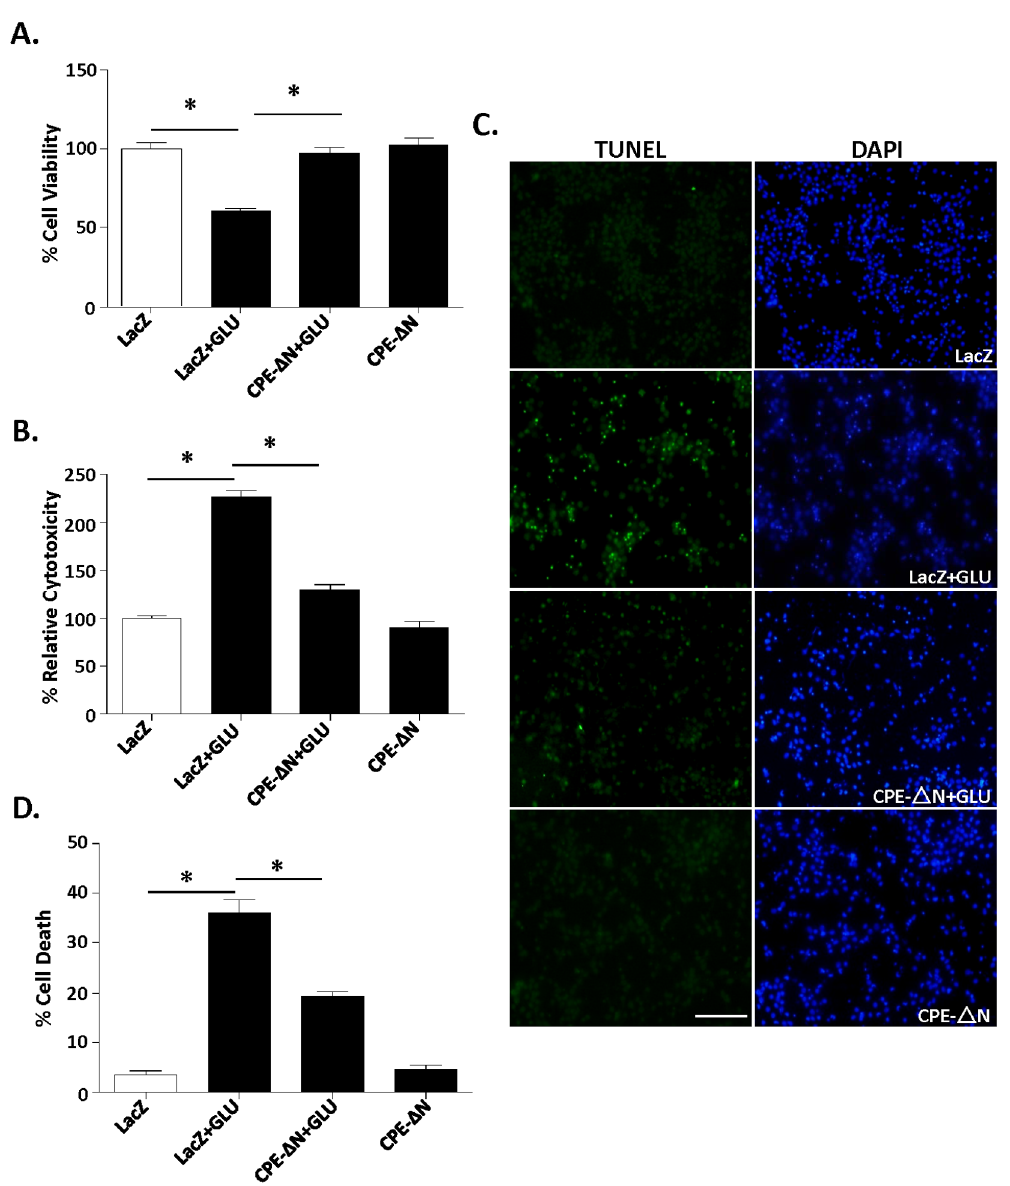
Figure 3. CPE- D N protects primary cortical neurons against glutamate-induced neurotoxicity. In A–D, rat primary cortical neurons were transduced with CPE- D N or LacZ viral vectors and subsequently treated with or without with glutamate for 24 h. A. Bar graphs show WST activity, indicative of cell viability. Note that the reduced cell viability after glutamate treatment was significantly increased in neurons transduced with the CPE- D N construct. At least three independent experiments were done. Data shown represent one experiment. B. Bar graphs show LDH release, indicative of cytotoxicity of cortical neurons. Note that the glutamate-induced cytotoxicity was significantly attenuated by the transduction of CPE- D N construct. At least three independent experiments were done. Data shown represent one experiment. C, D. Photomicrographs and bar graphs showing cortical neurons stained with TUNEL (green) and DAPI (blue). Note that the number of dead cells (green) increased significantly after glutamate treatment and that transduction of CPE- D N construct protected the neurons. The bar graphs represent the quantification of dead cells as a % of the total number of cells determined by the DAPI staining. At least 500 cells were counted in each of 3 different dishes generated from embryos from two independent experiments. Data shown represent one experiment. Bar 5 100 microns, n 5 6/group (A); 5/group (B) and 3/group (C). Values are mean ¡ SEM, one-way ANOVA followed by Tukey test, *p ,